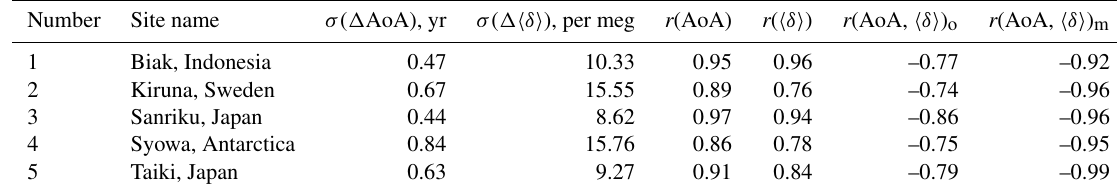
Figure 8. Same as Fig. 5 but over the Biak site for 22–28 February 2015. Table 3. Standard deviation of misfit between modeled and observed AoA and (cid:104) δ (cid:105) value ( σ ( (cid:49) AoA) and σ ( (cid:49) (cid:104) δ (cid:105) ), respectively); the Pearson correlation coefficient between modeled and observed AoA and (cid:104) δ (cid:105) value ( r (AoA) and r ( (cid:104) δ (cid:105) ), respectively); the Pearson correlation coefficient between AoA and (cid:104) δ (cid:105) from observation ( r (AoA, (cid:104) δ (cid:105) ) o ) and from the model ( r (AoA, (cid:104) δ (cid:105) ) m